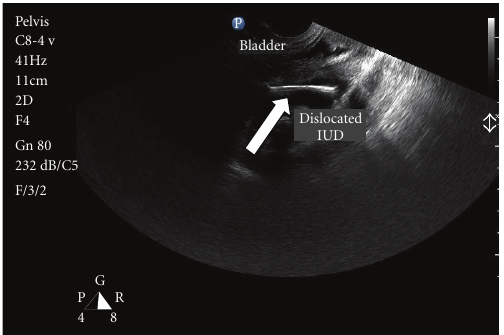
Figure 1: Transvaginal sonography showed a misplaced intrauter- ine device (arrow) that seemed to be located in the uterovesical space and embedded in the left posterior wall of the bladder.